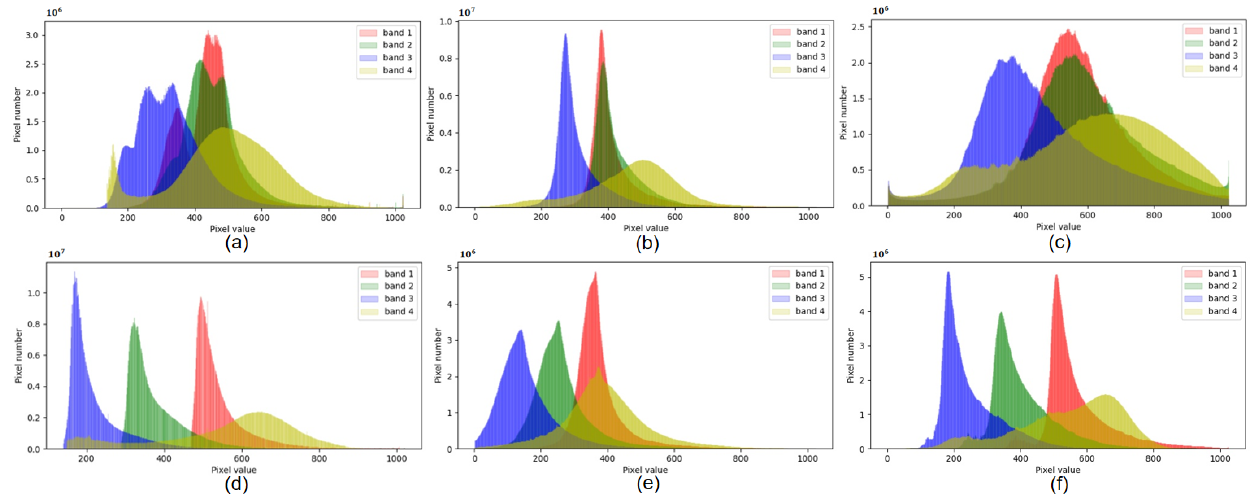
Figure 17. Color histograms of the Gaofen dataset. ( a ) GF-1. ( b ) Pseudo GF-1 transformed by color matching. ( c ) Pseudo GF-1 transformed by BiFDANet. ( d ) GF-1B. ( e ) Pseudo GF-1B transformed by color matching. ( f ) Pseudo GF-1B transformed by BiFDANet.